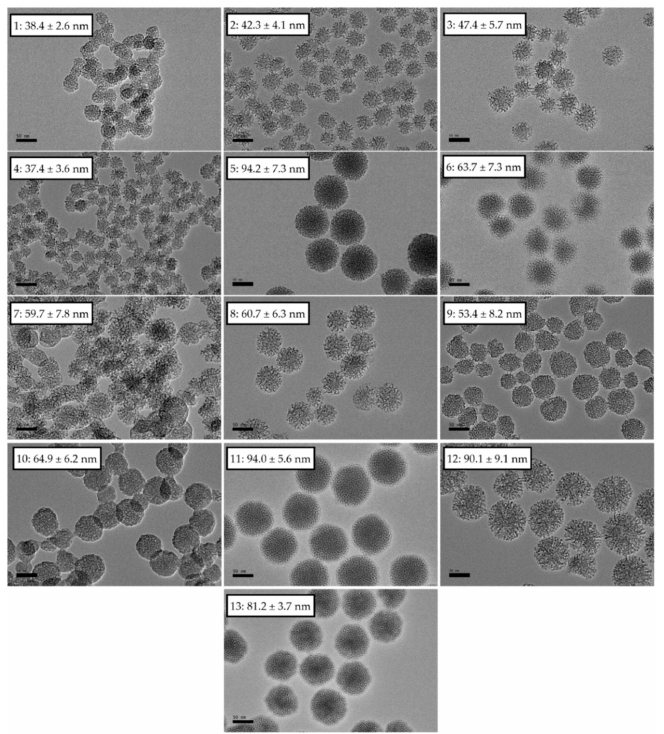
Figure 3. Transmission electron microscopy (TEM) images of synthesized MSNs corresponding to runs (Table 3).